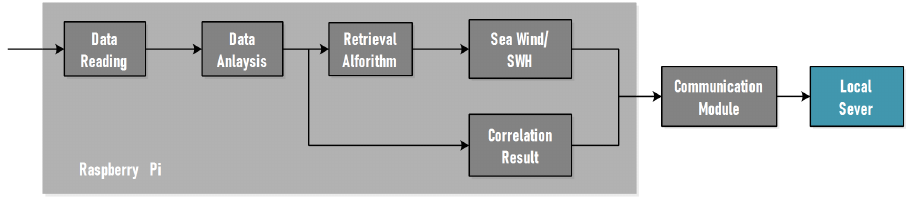
Figure 7. Retrieval unit